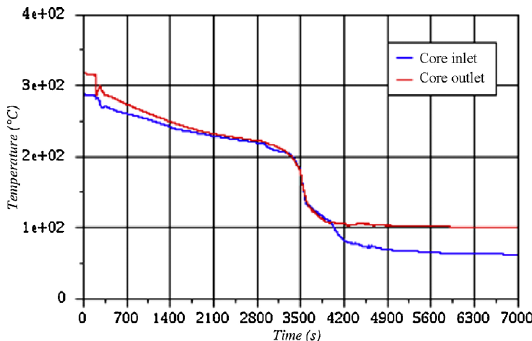
Fig. 24. Primary temperature ( °